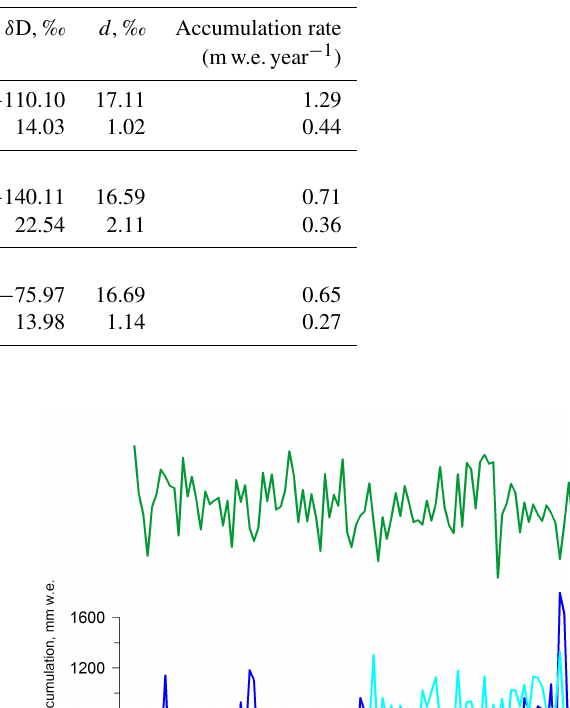
Table 3. Mean characteristics of the El’brus ice core records, calculated for the period from 1914 to 2013.